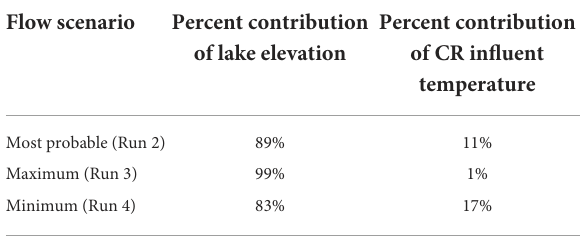
TABLE 3 F -test results to quantify the effect of predictors (lake elevation and Colorado River influent temperature) on intake 3 water